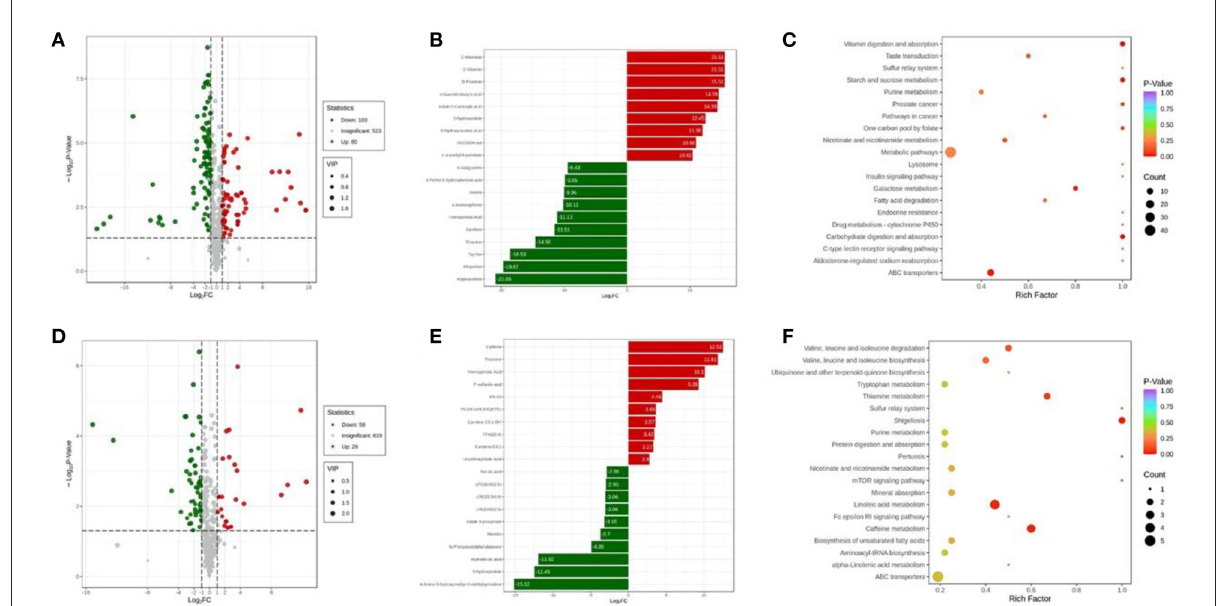
FIGURE3 (A) Volcano map of differentially expressed metabolites between Normal group and NASH group; (B) the top 20 differentially expressed metabolites with the largest fold changes between Normal group and NASH group; (C) the enrichment analysis of differentially expressed metabolites between Normal group and NASH group; (D) volcano map of differentially expressed metabolites between NASH group and Luteolin group; (E) the top 20 differentially expressed metabolites with the largest fold changes between NASH group and Luteolin group; (F) the enrichment analysis of differentially expressed metabolites between NASH group and Luteolin group. ( n = 6–8 per